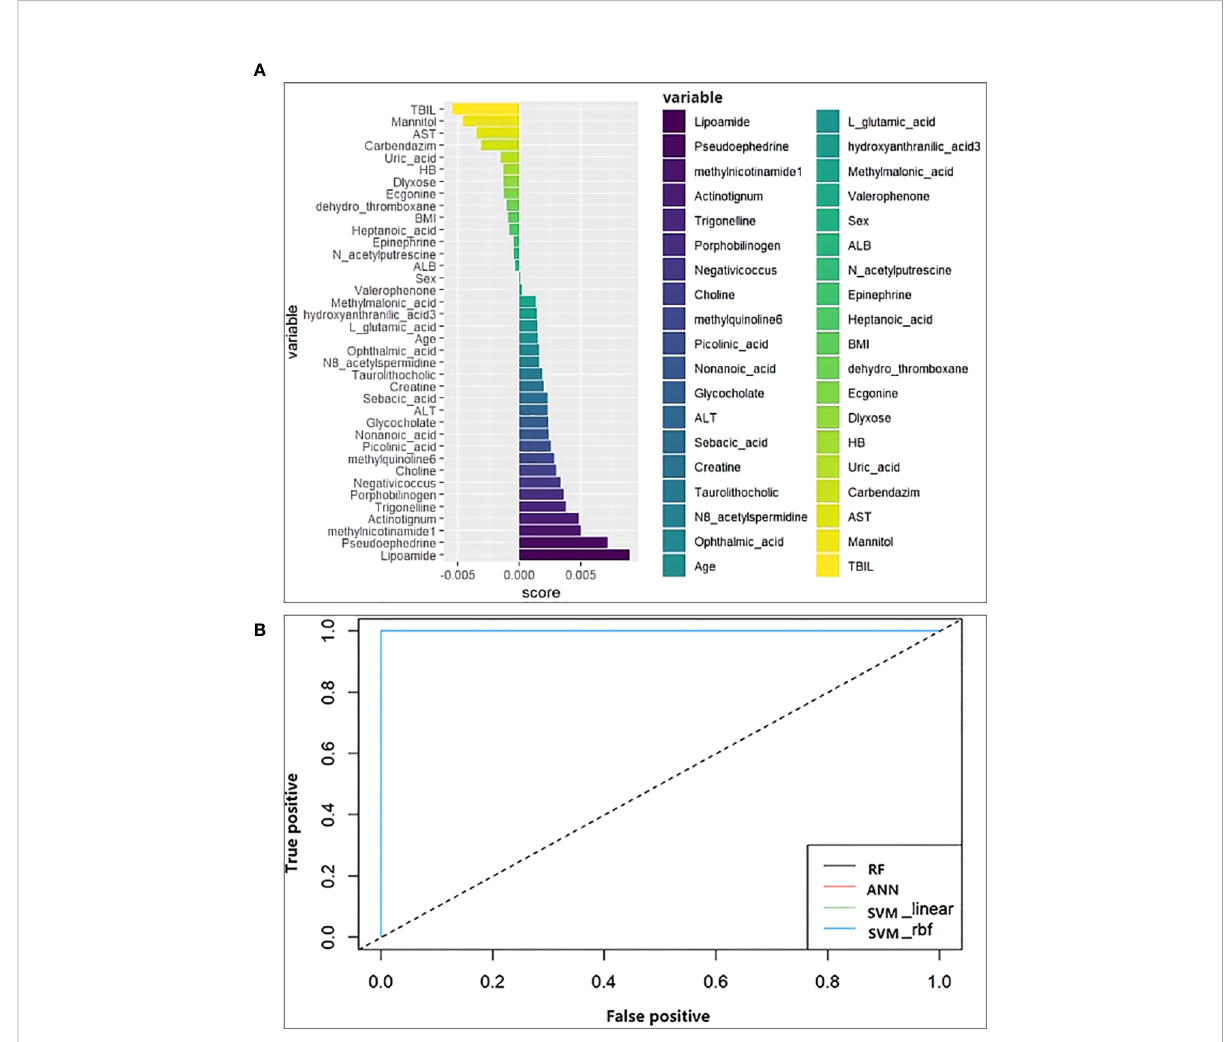
FIGURE 5 Machine learning models. (A) Score the importance of variables. The larger the value, the more important the variable is. (B) Receiver operating characteristic curve for the models developed with the top 10 important variables as inputs. ALT, alanine aminotransferase; AST, aspartate aminotransferase; TBIL, total bilirubin; ALB, albumin; BMI, body mass index; HB, hemoglobin.